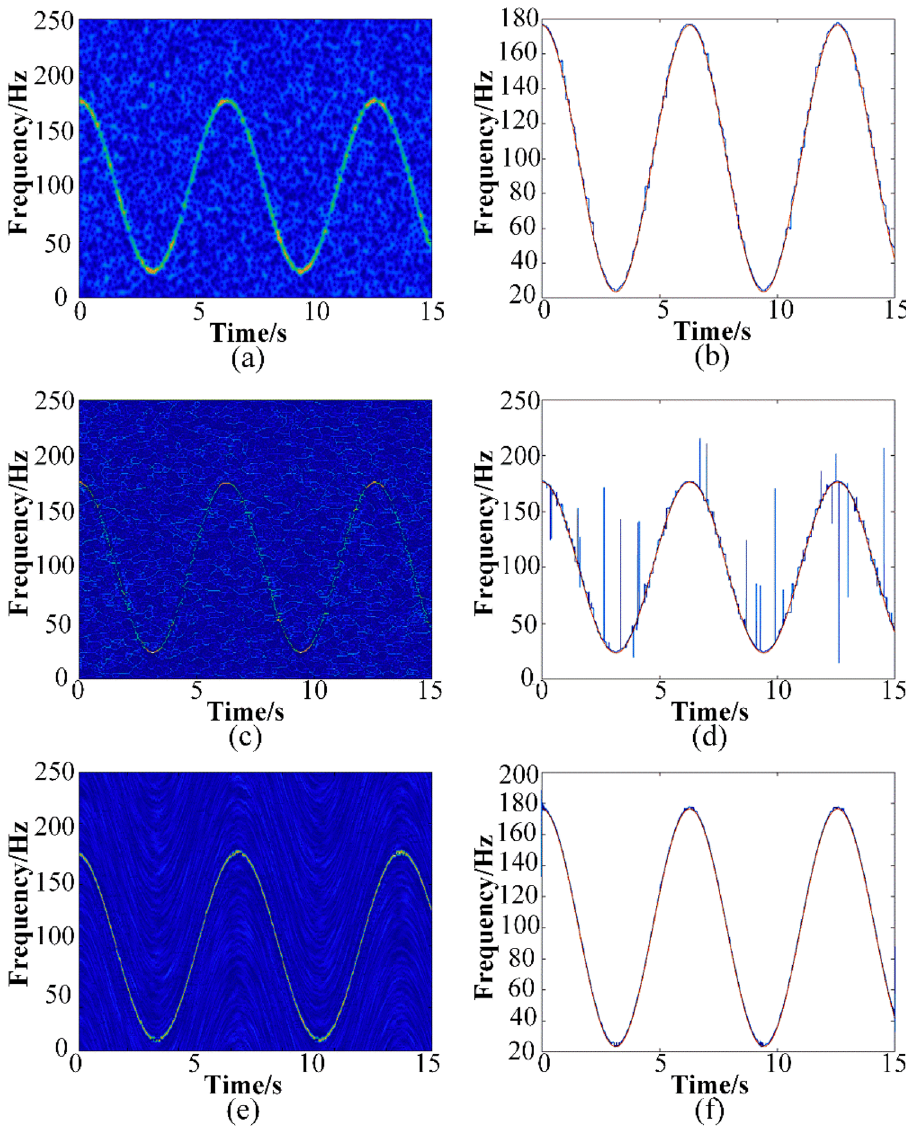
Figure 4. When SNR = 0 dB, ( a ) TFR result and ( b ) the IF detected by GWT, ( c ) TFR result and ( d ) the detected IF by SSET, ( e ) TFR result and ( f ) the detected IF by GWT–SSET, where the original IF (orange line), the estimated IF (blue line).